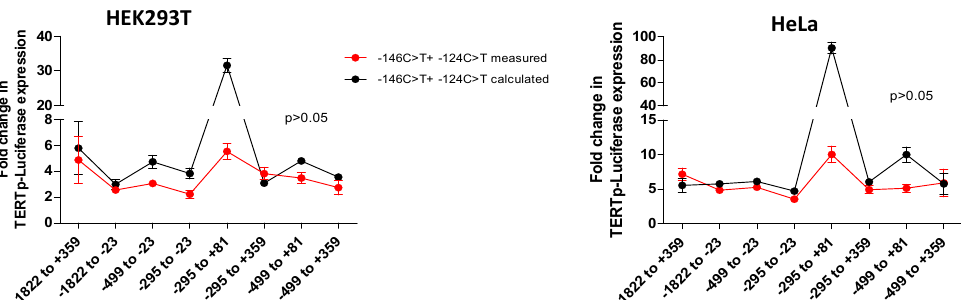
Figure 2. Impact of TERT promoter mutations − 146C>T and − 124C>T on TERT transcription. ( A , B ). Fold-change in TERT expression in HEK293T ( A ) and HeLa ( B ) cells transfected with the wt or mutant TERTp-luciferase reporter constructs. HEK293T (1.2 × 10 5 cells/well) or HeLa (5 × 10 4 cells/well) were seeded in a 48-well plate and transfected with 200 ng of each of the wt (black) or mutated (green: − 146C>T; blue: − 124C>T; red: − 146C>T + − 124C>T) TERTp-luciferase reporters + HSV-TK-Renilla-luciferase for normalization (10 ng in HEK293T and 20 ng in HeLa) for 48 h. Firefly Luciferase RLU was normalized to Renilla Luciferase RLU and transcription levels were further normalized to the wt for each TERT promoter construct. Results are the mean of at least 3 independent experiments carried out in duplicate. Error bars represent standard error. Differences were compared using a one-way ANOVA followed by a Newman–Keuls post-hoc test for pairwise comparisons. * indicates p < 0.05, ** indicates p < 0.01, *** indicates p < 0.001. ( C ). Comparison of the measured and estimated fold increase in TERT expression for the double mutant. The fold increase in TERTp-luciferase expression measured for the double mutant (red) was compared with the calculated sum of the fold increase due to the − 146C>T mutation + − 124C>T mutation (black).